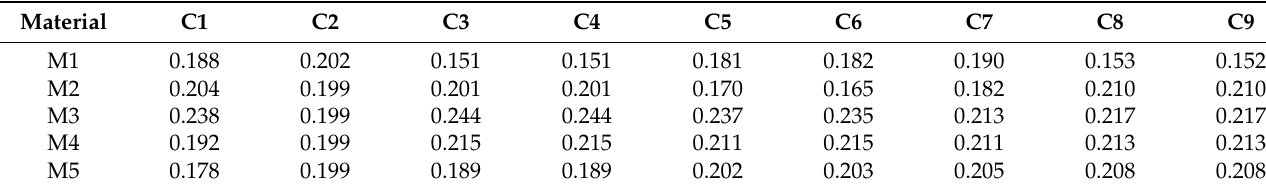
Table 8. Entropy Table 7. Entropy matrix P ij .